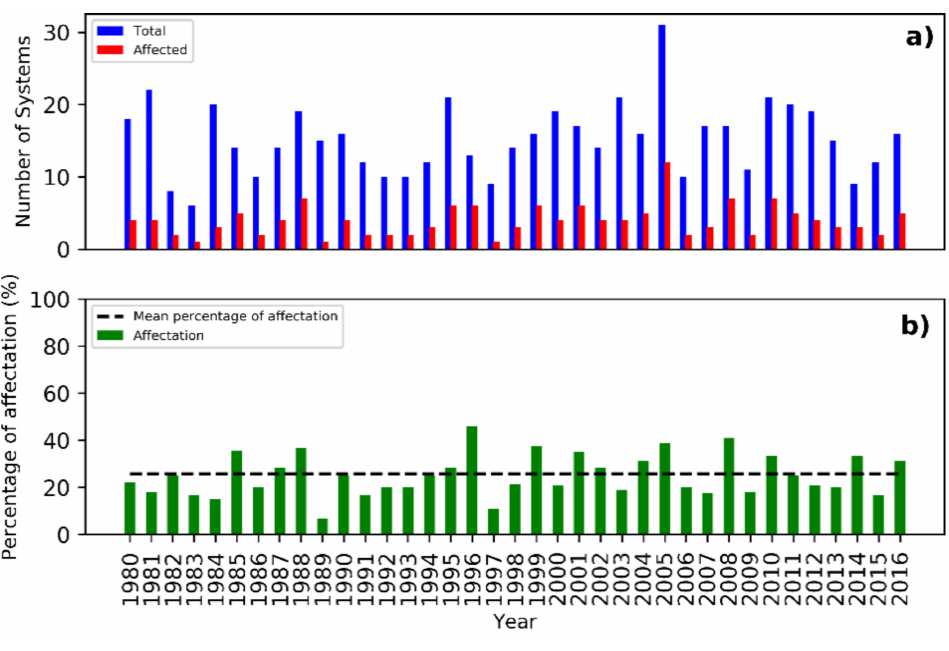
Figure 2. ( a ) Total number of tropical cyclones (TCs) formed in the whole North Atlantic Ocean basin (blue bars), and those that a ff ected Cuba (red bars). ( b ) Percentage of TCs that a ff ected the Cuban mainland. Period: June to November 1980-2016.